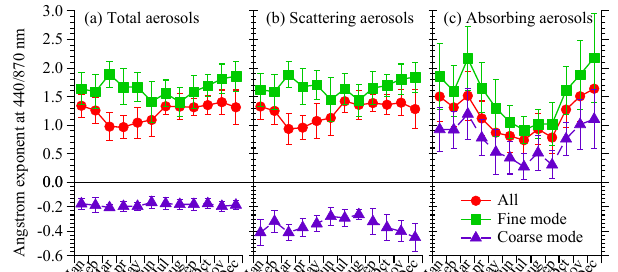
Figure 3. Monthly variations in the all, fine and coarse-mode aerosol single scattering albedo (SSA) at 550nm (a) and the aerosol refractive indices at 440nm (b) in the urban area of